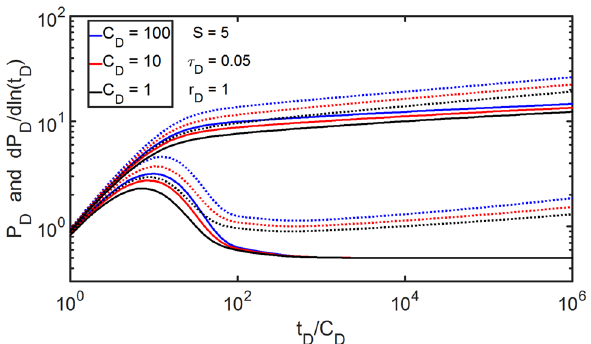
Fig. 3 Pressure and pressure derivative, non-linear (broken curves) and linear (solid curves) responses. From Jelmert and Toverud (2017a)